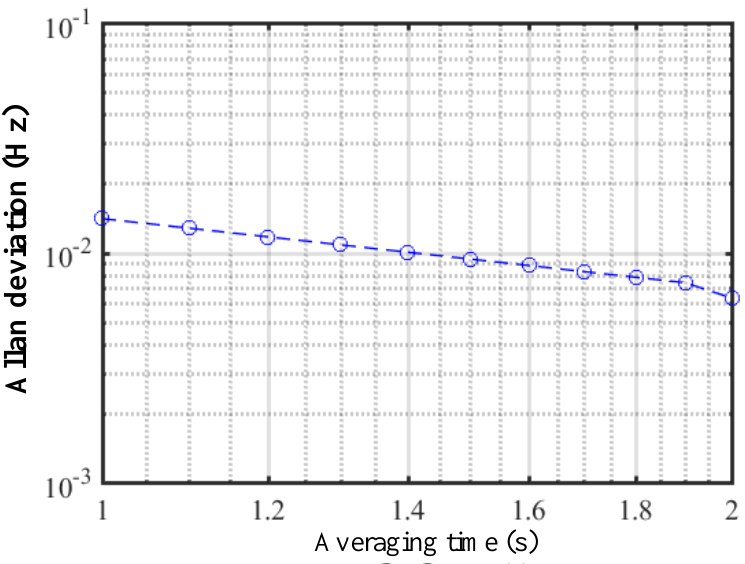
Figure 5. Allan deviation of 1 MHz frequency.